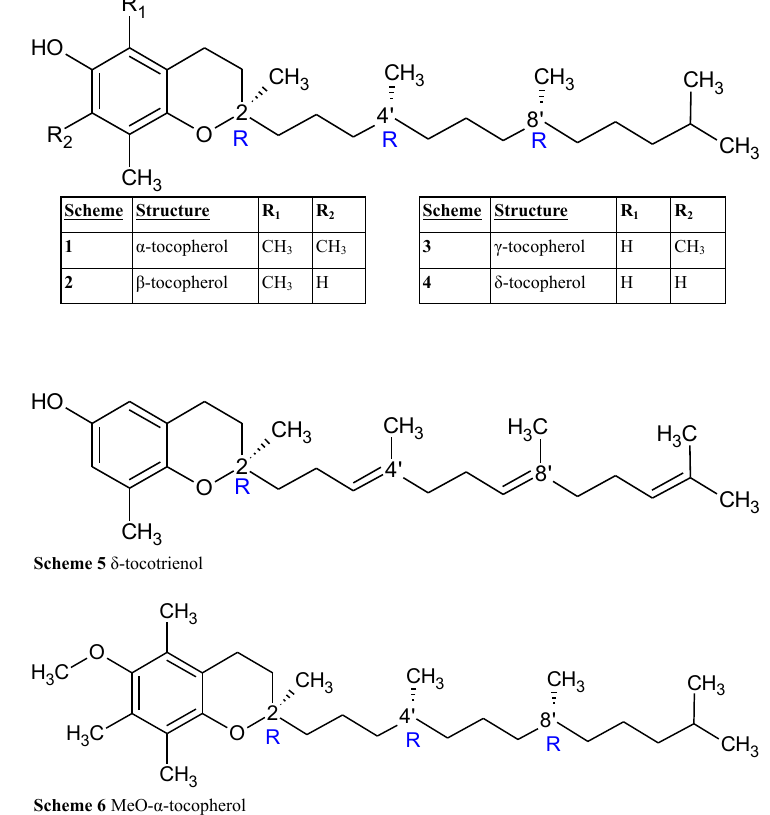
Figure 1. The chemical structures of the examined vitamin E